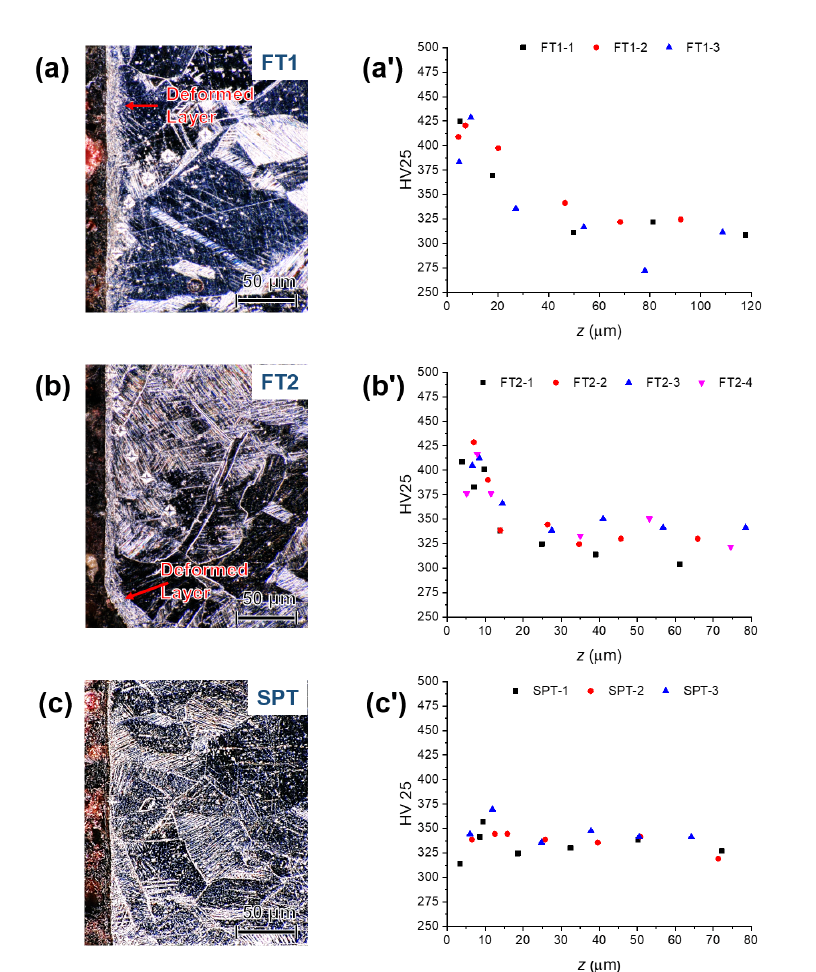
Figure 5. Microstructure and microhardness–depth profiles close to annulus and chamfer surfaces (on the left side) of as-machined nuts. ( a , a ’) FT1. ( b , b ’) FT2. ( c , c ’) SPT.